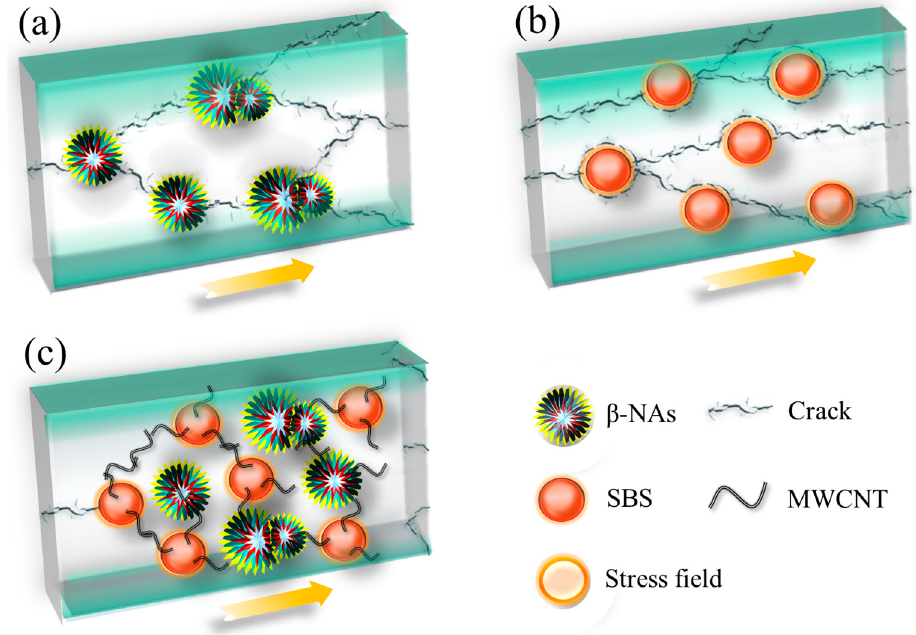
Figure 10. Schematic diagram of toughening mechanism of PPR blends ( a ) β -NAs/PPR; ( b ) SBS/PPR; ( c ) ternary (MWCNTs + β -NAs + SBS)/PPR.